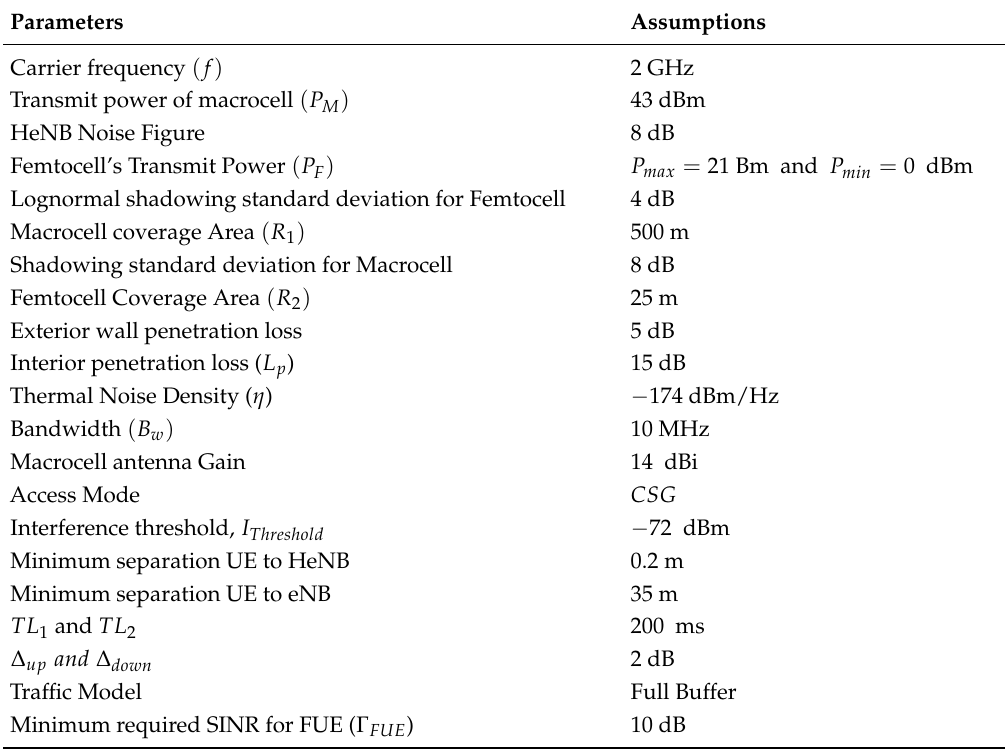
Table 2. Simulation